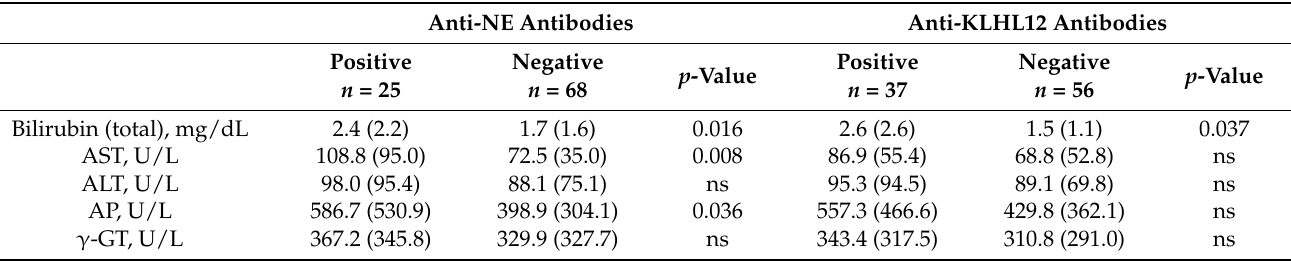
Table 4. Data from biochemical analyses of 138 PBC patients, and the anti-NE and anti-KLHL12 antibodies status.